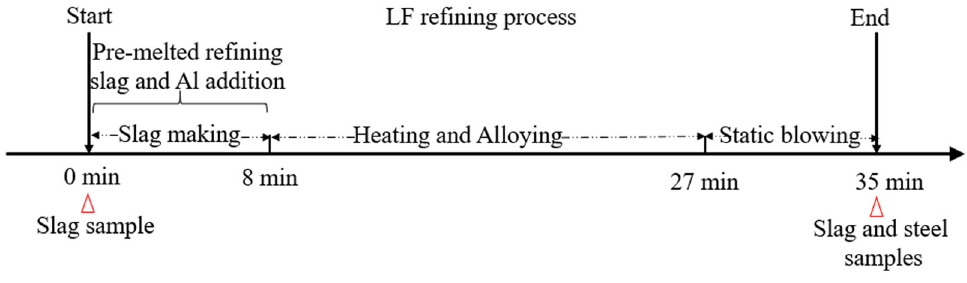
Figure 2. The sketch diagram of LF refining process and sampling time of Al-killed ULC automotive